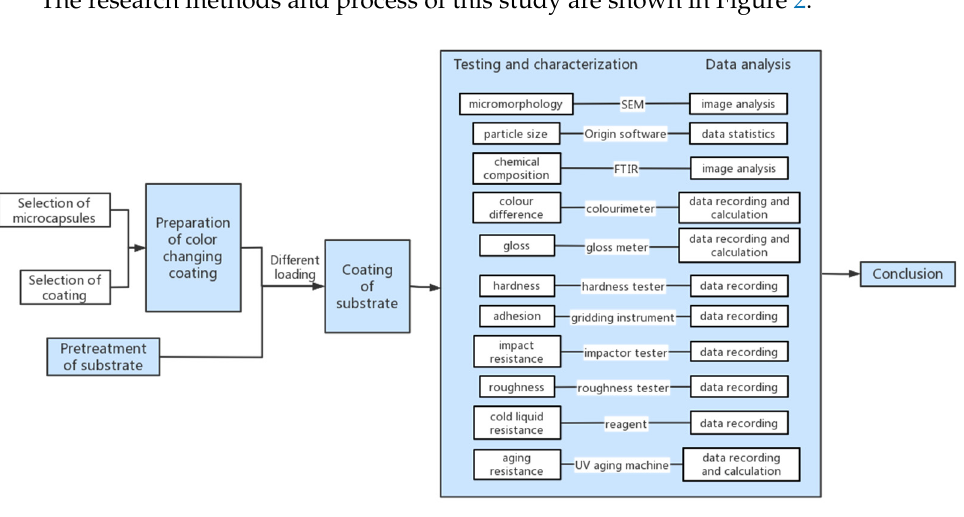
Figure 2. The research methods and process.